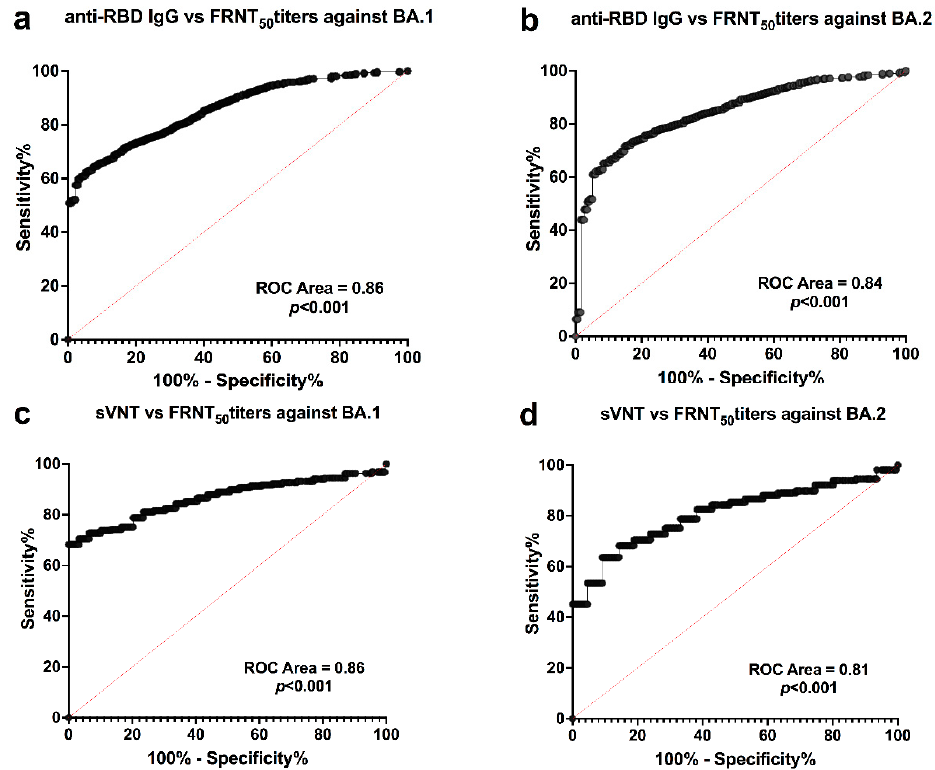
Figure 2. ROC analysis between anti-RBD IgG, surrogate virus neutralization test (sVNT), and FRNT50 titers against omicron BA.1 and BA.2. ROC analyses for anti-RBD IgG tested at cut-off value FRNT50 titer = 20 against BA.1 (Panel ( a )) and BA.2 (Panel ( b )). ROC curve of sVNT tested at cut-off value FRNT50 titer = 20 against BA.1 (Panel ( c )) and BA.2 (Panel ( d )).